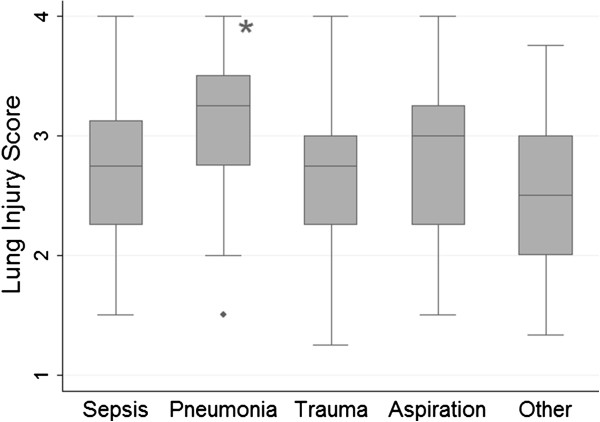
Box plot comparison of Lung Injury Score according to acute respiratory distress syndrome (ARDS) risk factor in 550 patients with Berlin-defined ARDS. The line in the middle of the box represents the median and the lines that form the box correspond to the 25th and 75th percentiles. The LIS differs significantly across ARDS risk factor group, which is driven by an increased LIS among patients with pneumonia, P < 0.0001. Compared to all other causes of ARDS, mean baseline LIS for patients with pneumonia as a primary cause of ARDS is 0.5 points higher (95% CI 0.3 to 0.6).